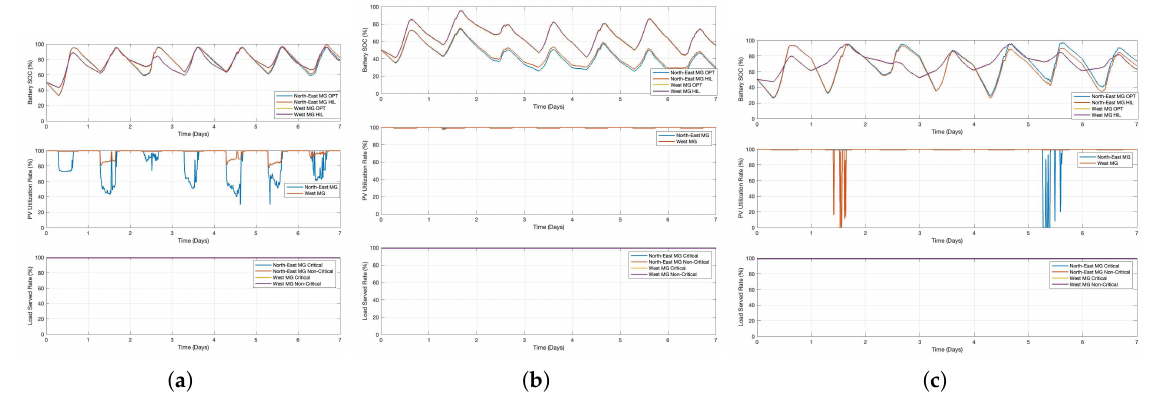
Figure 19. HIL testing results of the Adjuntas 2-microgrid system in various cases. ( a ) Case 1. ( b ) Case 2. ( c ) Case 3.